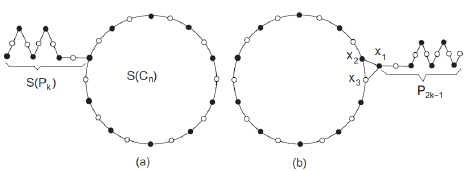
Figure 1. ( a ) Subdivision graph of the tadpole graph T n , k ; ( b ) Line graph of the subdivision graph of ( T n , k )